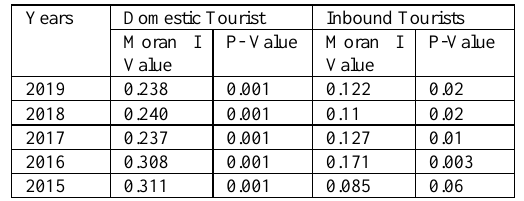
Table 1: The Moran’s I values for domestic and inbound tourist arrivals